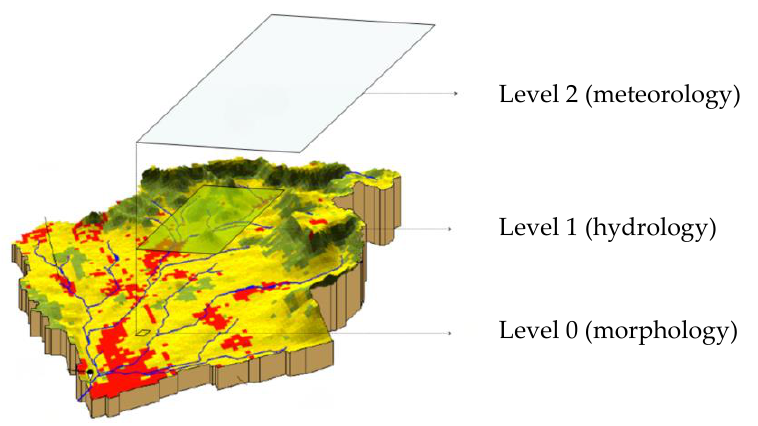
Figure 2. Spatial scales in model structure i.e., L0 is morphology, L1 is hydrology, and L2 is coarse meteorologic forcing scale (from https://www.ufz.de/index.php?en=40114; (accessed on 10.11.2022) .